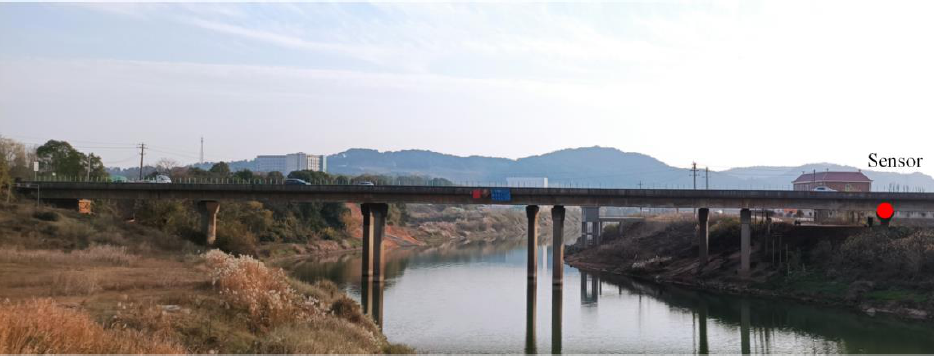
Figure 12. Bridge overview and installation point (red dot) of the inclinometer.